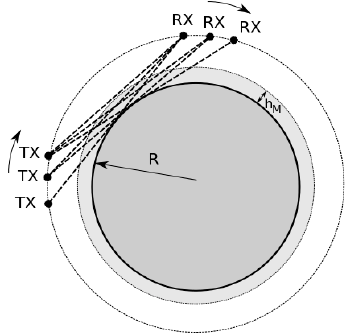
Figure 1. Acquisition scheme of the NDSA measurements of IWV for a system of co-rotating LEO satellites (h M is the thickness of the annular region where it is possible to retrieve the WV field). In the example, three satellites with a Tx onboard and three satellites with a Rx onboard enable the creation of nine tropospheric links (of which only six are shown in the figure); thus, nine simultaneous measures of IWV are available after every integration interval.